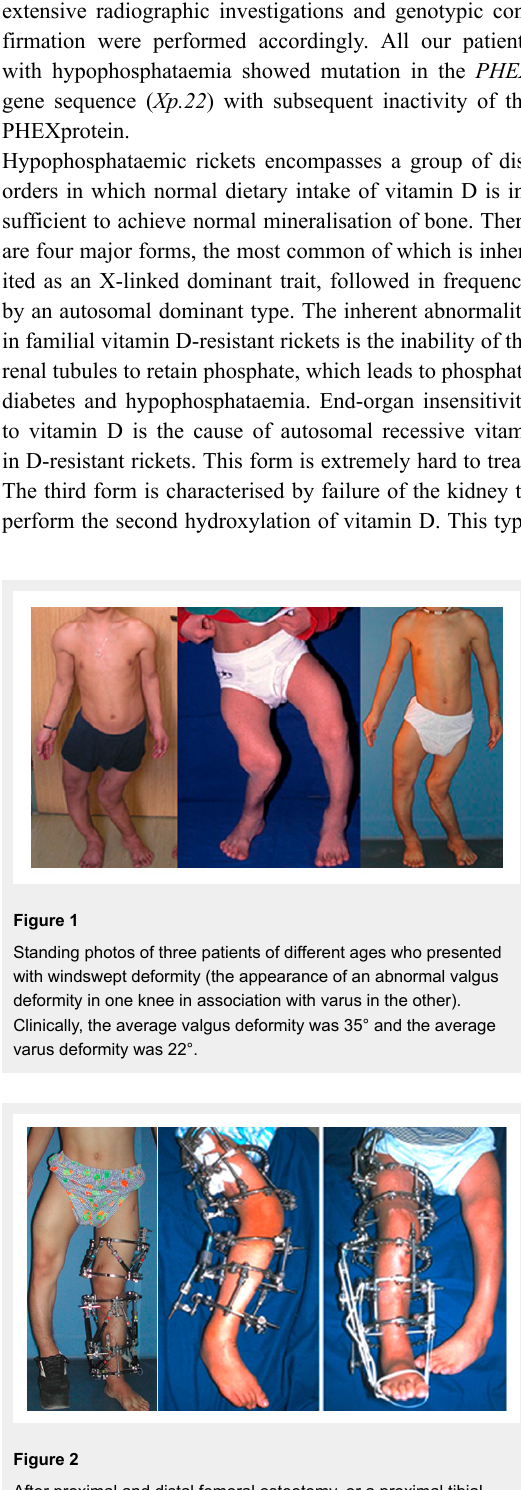
After proximal and distal femoral osteotomy, or a proximal tibial osteotomy of the lower limbs (in different patients), a Taylor spatial frame was